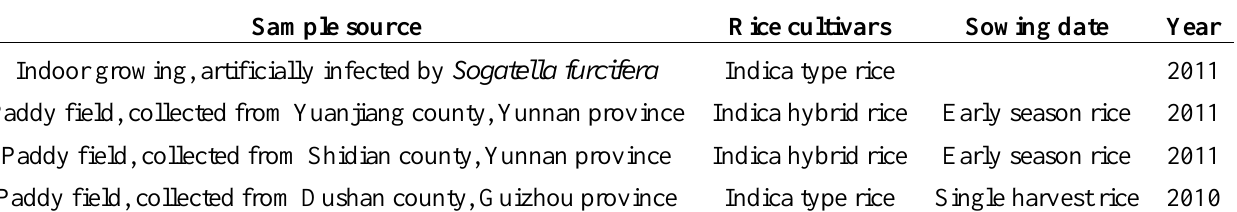
Table 5. Information on the rice materials used in the